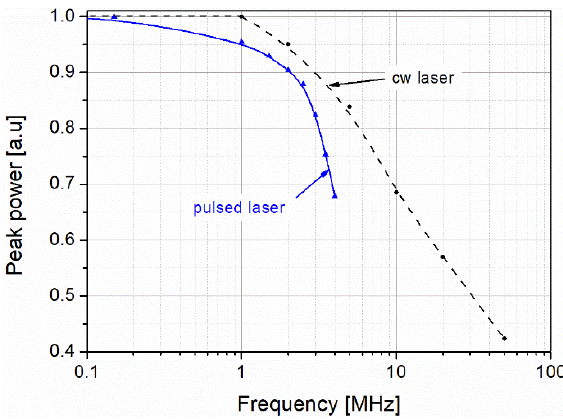
Figure 11. Peak power vs. pulse frequency (pulse duty cycle).